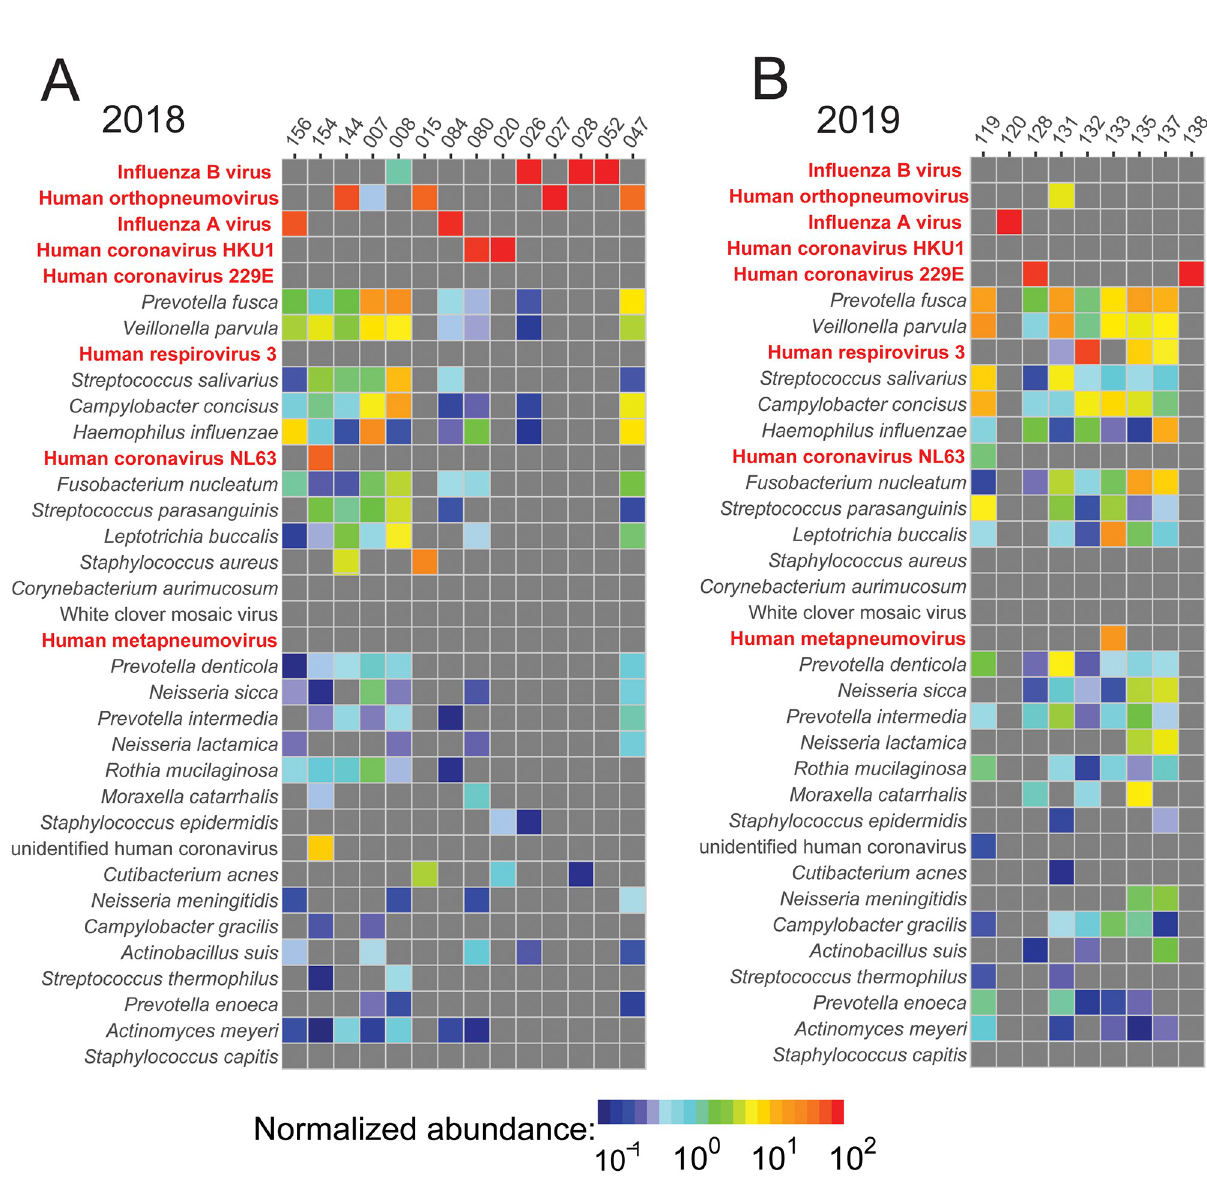
Fig 3. Heat maps of target viral pathogens (species in red) and other viral and bacterial species from (A) 2018 and (B) 2019 from RNA sequencing using the PanGIA taxonomic tool. Species are ordered from most abundant to least abundant. Abundance is normalized and is designated by color (red colors refer to more abundant species, while blue colors refer to least abundant